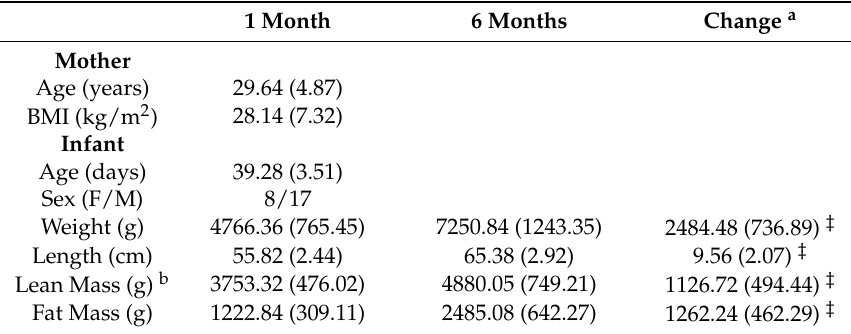
Table 1. Participant